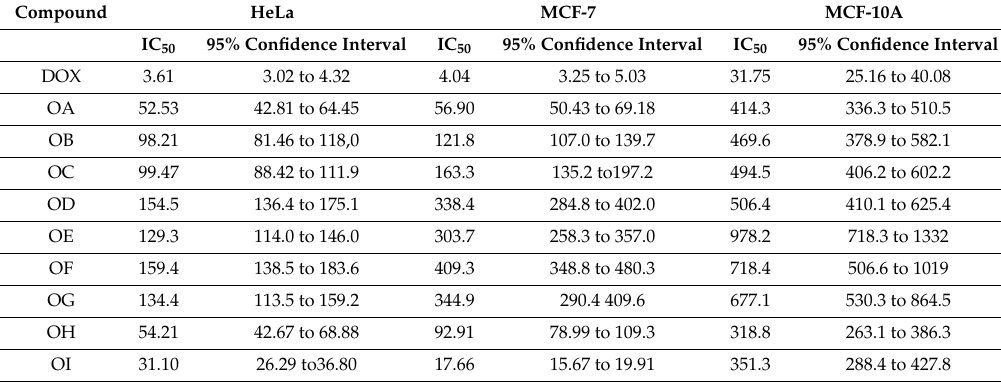
Table 1. Cytotoxic activity of 5-(Carbamoylmethylene)-oxazolidin-2-ones in comparison to that of doxorubicin a